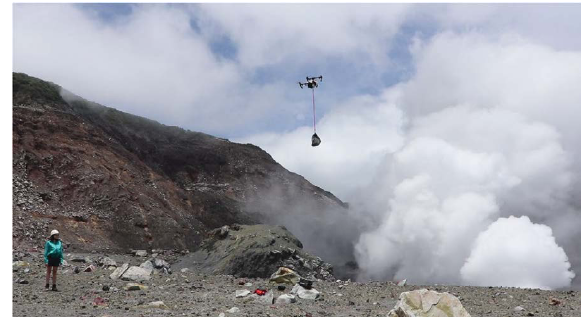
Figure 16: Aerial survey of gas concentrations in the volcanic plume of Villarrica, Chile (20 March 2018); for scale, the crater rim is ~200 m in diameter. Data acquired using a multi-rotor UAS mounted with Aeris sensor unit (Air Quality Innovations Ltd, Australia), sampling at a frequency of 1.25 Hz. Symbols indi- cate sampling locations, coloured according to the mea- sured SO 2 concentration in parts per million (ppm).